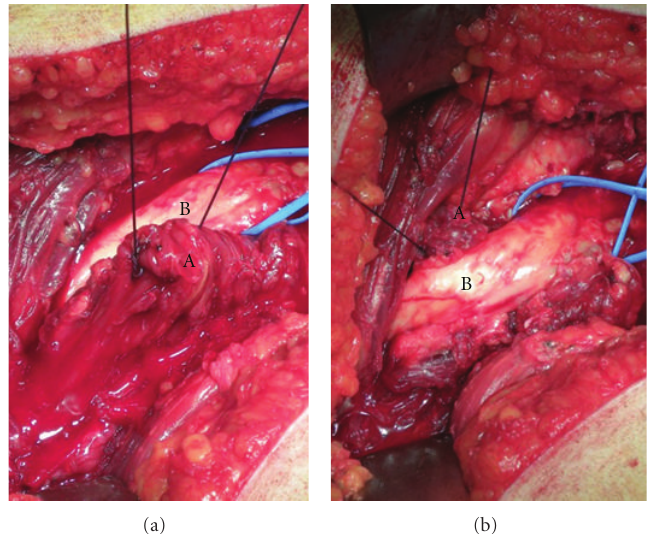
Figure 4: The muscular flap (A) positioned between the sciatic nerve (B) and the metallic cage: (a) preparation of the flap, (b) the flap in its final